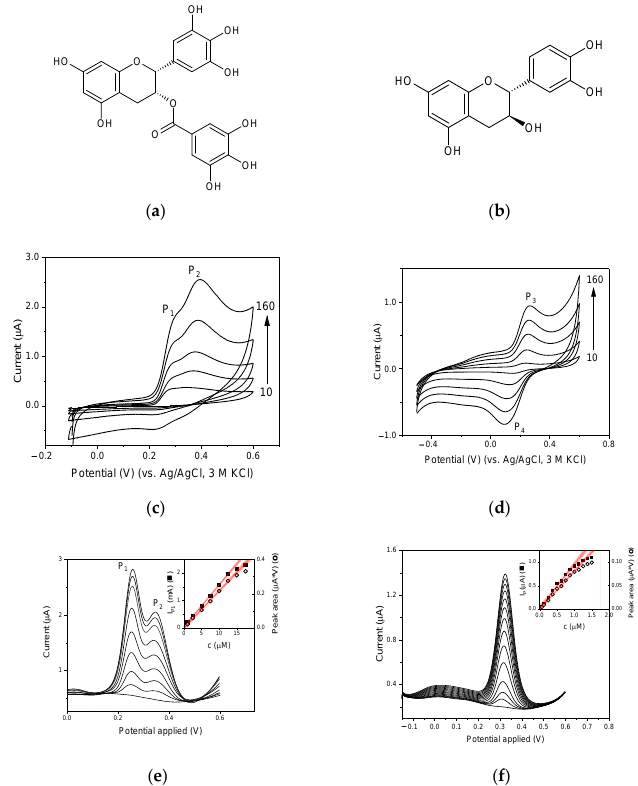
Figure 6. Chemical structures of ( a ) epigallocatechin gallate and ( b ) catechin. Cyclic voltammograms of GC n paste electrode recorded in ( c ) 0.5 mM catechin and ( d ) 0.5 mM epigallocatechin gallate in 0.1 acetate buffer (pH = 4.5) at different scan rates of 10, 40, 80, 120, and 160 mV/s. DP voltammograms recorded using GC n /PDMS in 0.1 M acetate buffer containing ( e ) 1 – 17.5 µM of epigallocatechin gallate and ( f ) 0.06 – 1.50 µM of catechin. The insets show corresponding calibration plots for the peak current (full square) and the peak area (open circles). Instrumental parameters: accumulation potential, E acc = − 0.1 V (epigallocatechin gallate), or E acc = − 0.3 V (catechin), accumulation time, t acc = 10 s (epigallocatechin gallate) or t acc = 5 s (catechin), modulation amplitude, E = 50 mV, potential step, E s = 3 mV.